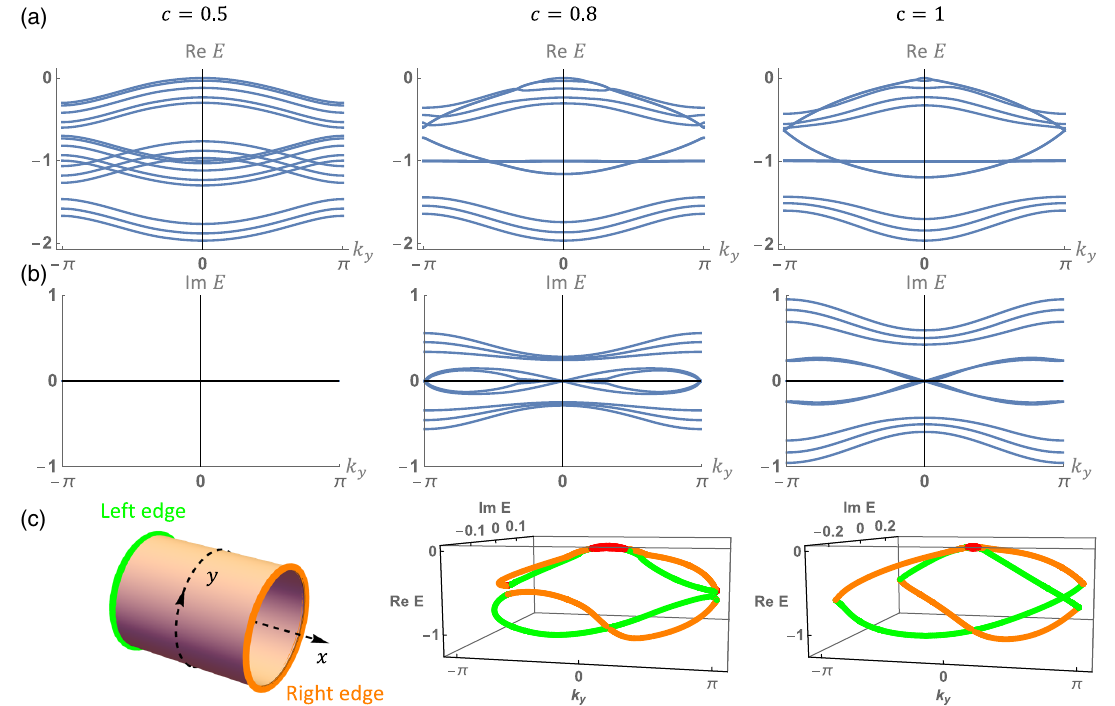
FIG. 5. Emergence of edge states and the non-Hermitian topological invariant, vorticity. (a) Using a half-periodic geometry with OBC in x and PBC in y , we calculate the band structure of the system along the reciprocal lattice index k y . In the Zak phase at r ¼ 0 . 7 , we show three examples as the system is varied from the Hermitian case with equal forward and reverse transitions ( c ¼ 0 . 5 ) to the full chiral case with only forward transitions at c ¼ 1 . Left panel: In the Hermitian limit, all the bands have similar amounts of group velocity d ð Re E Þ =dk c increases, bands localized on the edge emerge, which are the bands with the y or bandwidth. Center and right panels: As largest group velocity. (b) Left panel: When W is Hermitian, its bands are completely real. Center and right panels: W is non-Hermitian ( c ≠ 0 . 5 ), and its bands have an imaginary component that increases in magnitude with c . (c) Left panel: schematic of the semiperiodic geometry with different bands localized on the system edge. Center and right panels: edge states, i.e., the two pairs of bands with the largest group velocity, in complex space. Parts of the bands are completely real (red) and distributed in equal amounts on the left and right edges. As chirality increases (center, c ¼ 0 . 8 ), they increasingly split in complex space and become localized on the left (green) and right (orange) edges, respectively, but still exhibit a vorticity of ν ¼ 0 . For sufficiently strong chirality (right, c ¼ 1 ), a transition occurs when the two pairs of edge bands touch in real space, exhibiting a doubled periodicity of 4 π and vorticity of ν ¼ 1 = 2 . All panels use N x ¼ 3 and give values of E in units of γ tot